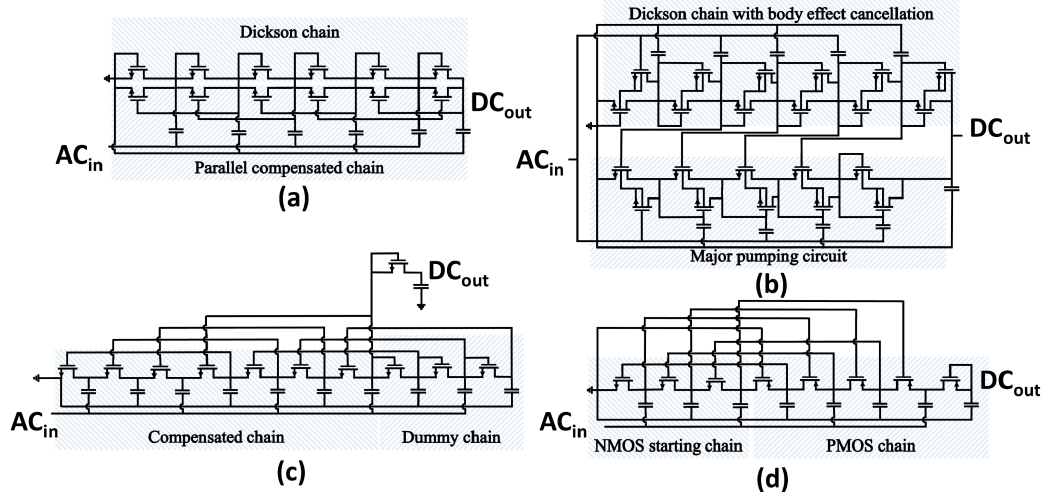
Figure 9. Prior-art threshold-compensation techniques for multi-stage voltage multipliers. ( a ) V TH -reduction technique through charge transfer switches [30]. ( b ) Threshold-compensation through body effect reduction and parallel compensated chain [14]. ( c ) V TH -cancellation technique through a constant order forward compensated NMOS chain [18]. ( d ) V TH -compensation technique realized with NMOS and PMOS transistors forward and backward compensated, respectively